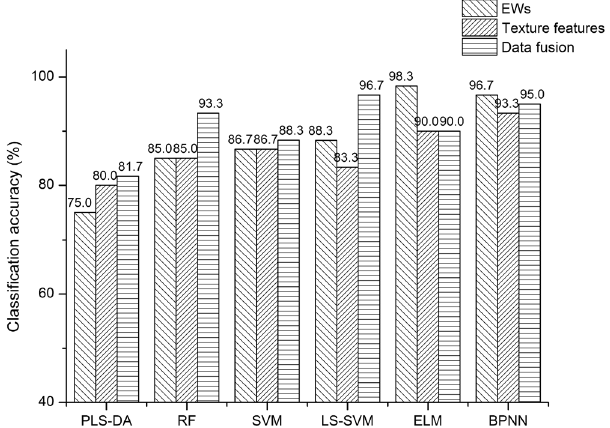
Figure 4. Performance comparison of different machine-learning classifiers including partial least squares- discrimination analysis (PLS-DA), random forest (RF), support vector machine (SVM), back propagation neural network (BPNN), extreme learning machine (ELM) and least squares support vector machine (LS-SVM) with EWs, texture features and data fusion for four-class